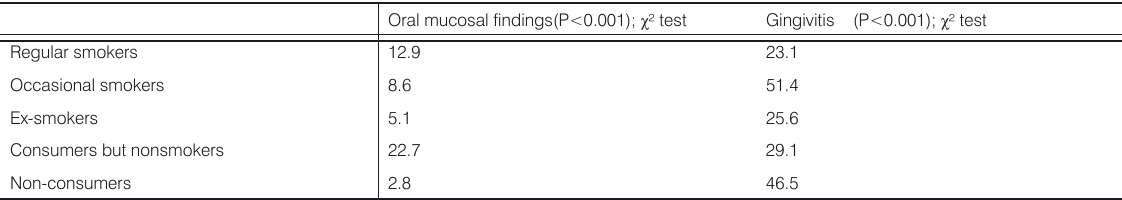
Table 4. Percentage of respondents with oral mucosal findings and